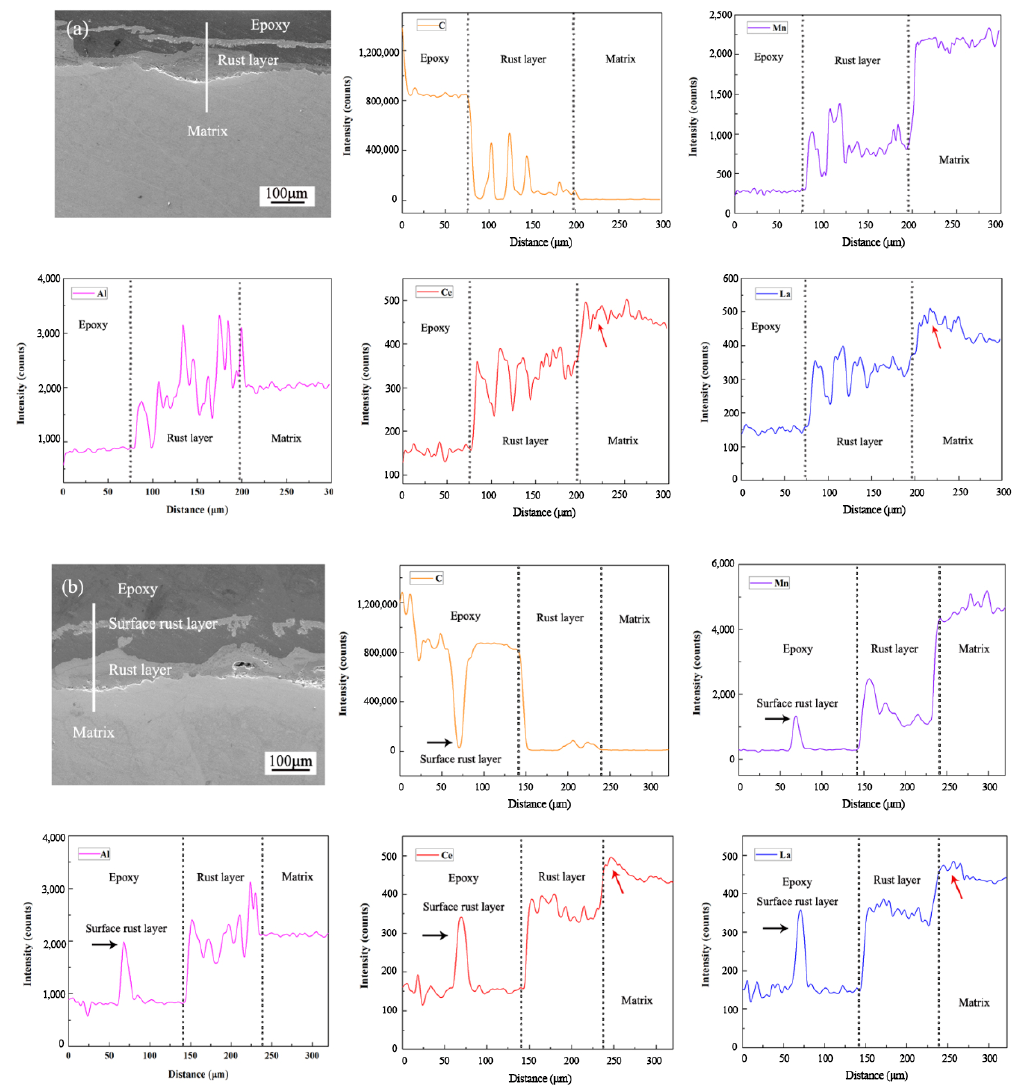
Figure 6. Element distribution in rust layers after 144 h immersion tests ( a ) Q235BM ( b ) Q355BM.